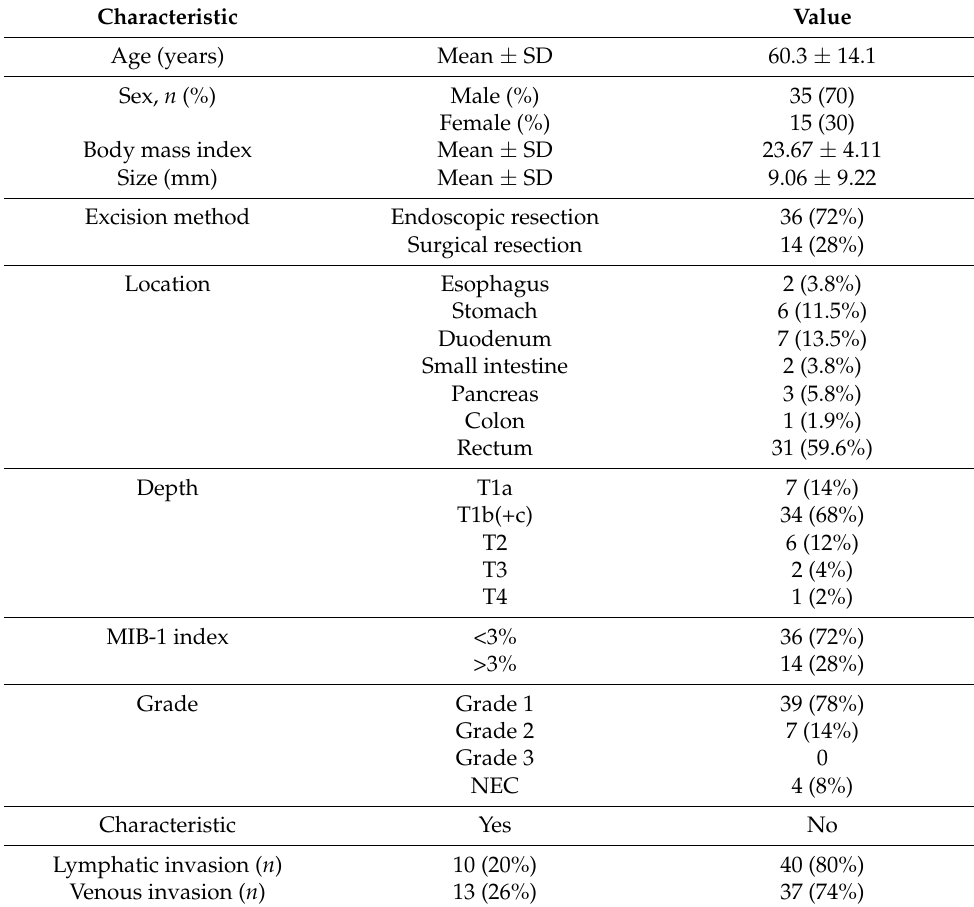
Table 1. Background characteristics of neuroendocrine tumors ( n =